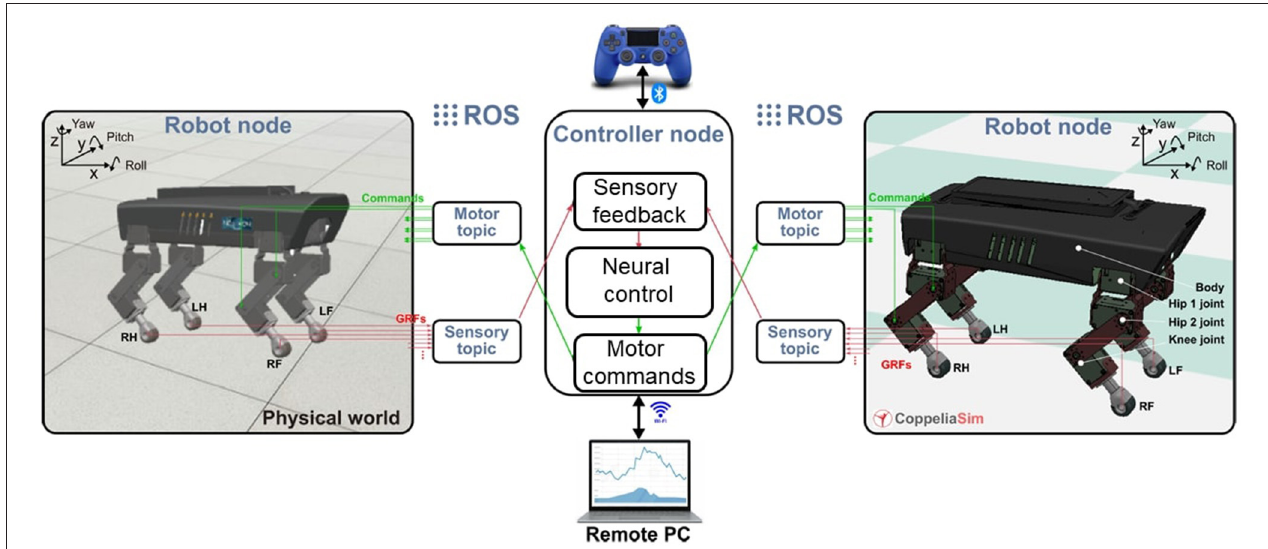
FIGURE 1 | Overview of the 12 DoF quadruped Lilibot. Lilibot has a software framework with a modular design. The framework is based on the robot operating system (ROS) and can be connected to a joystick and a remote computer for manual control and robot state monitoring/recording. The simulated and physical versions of Lilibot are identical. A control mechanism can be first tested on the simulated robot and then directly transferred to the actual robot. Further details are reported in Sun et al. (2020).